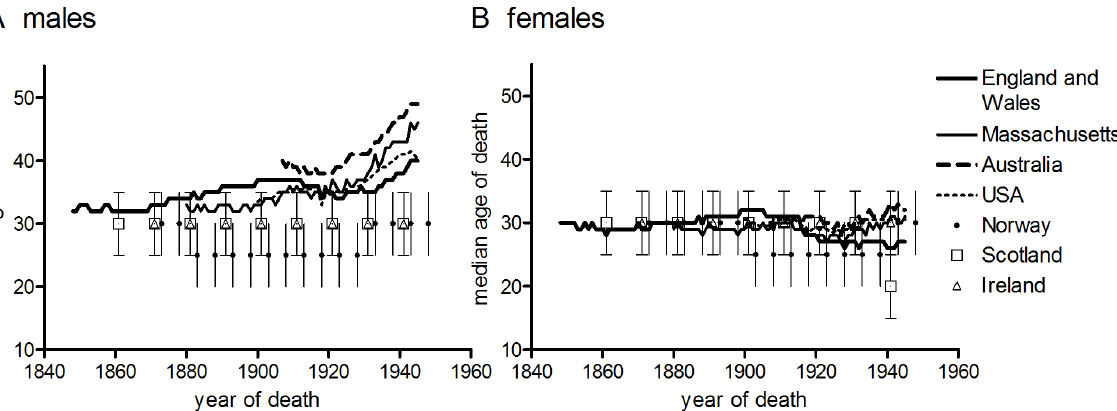
Figure 3. Median age at death from tuberculosis, by year of death. Calculated by indirect standardisation of deaths at ages 10–79 years.